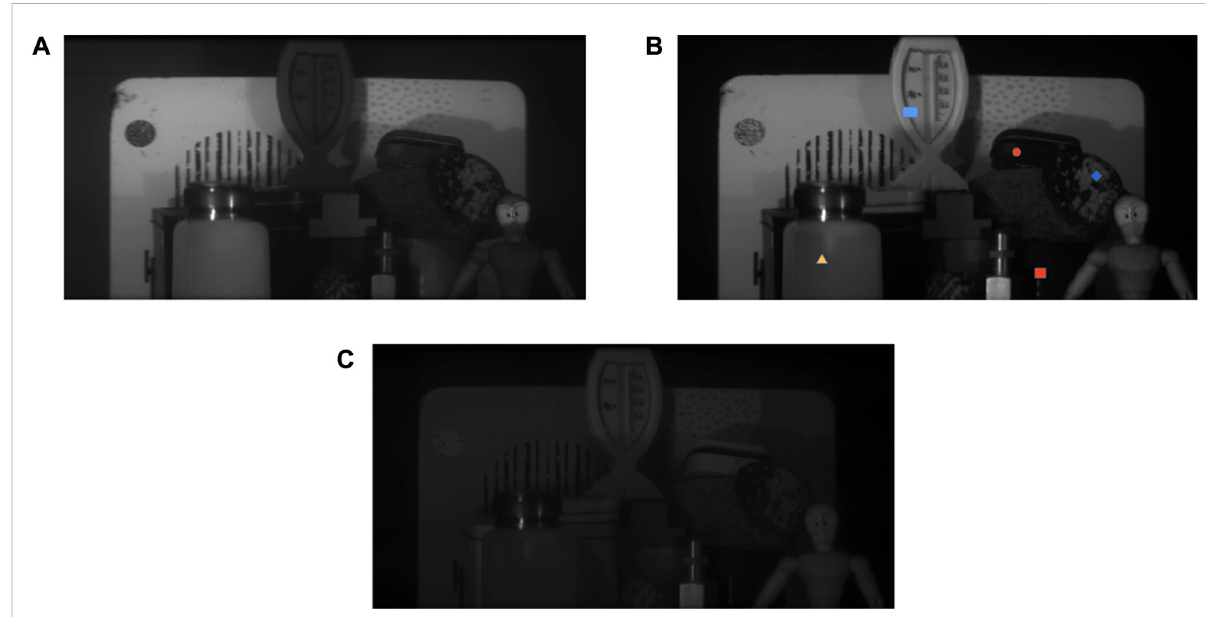
FIGURE 14 Monochromatic images of the different objects. (A) Monochromatic images of different objects at 455 nm. (B) Monochromatic images of different objects at 555 nm. (C) Monochromatic images of different objects at 655